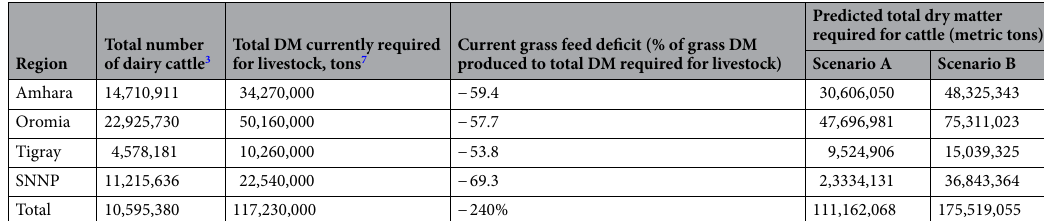
Table 3. Total dairy livestock numbers and resulting feed requirements under Scenario A (93% local stock and 7% exotic breeds) and Scenario B (60% local stock and 40% exotic breeds).